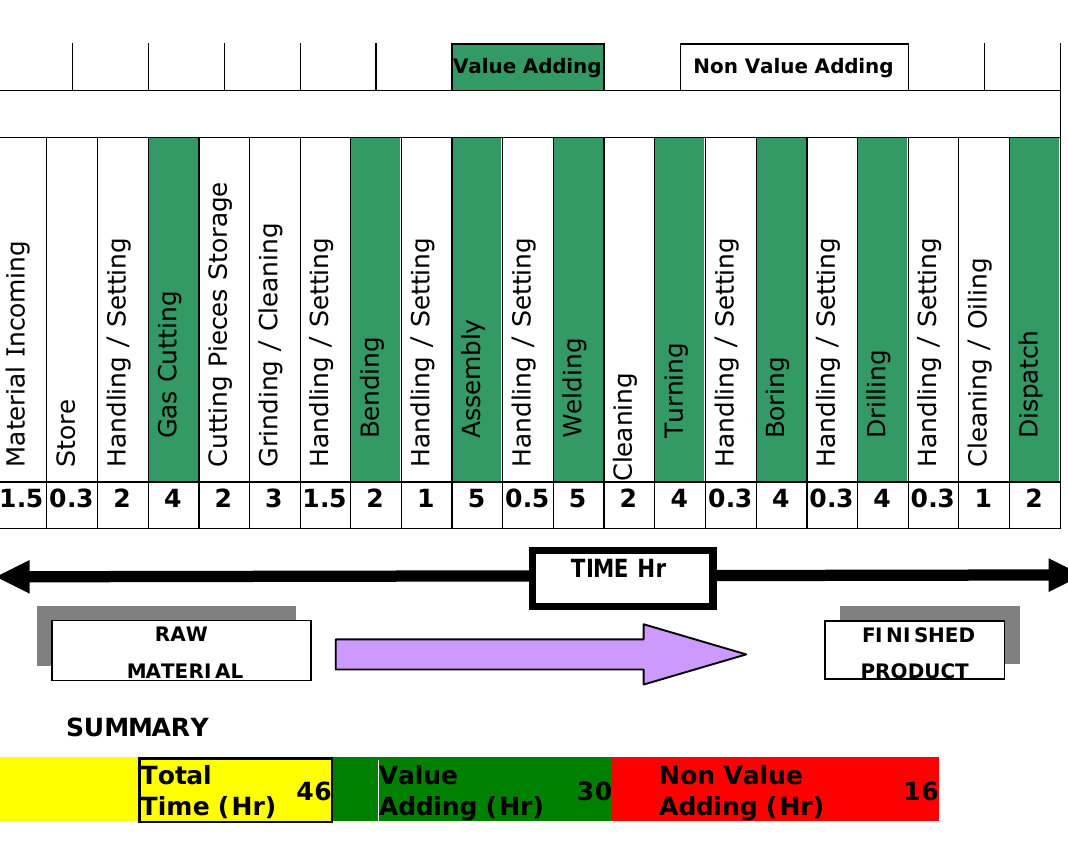
Figure 2. “Value stream mapping before root cause